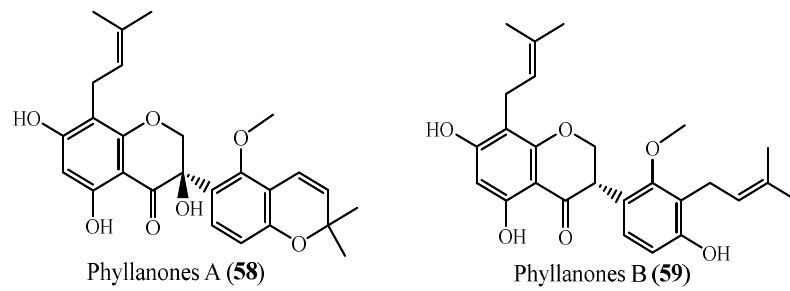
Figure 1. Structures of the examined isoflavonoids.